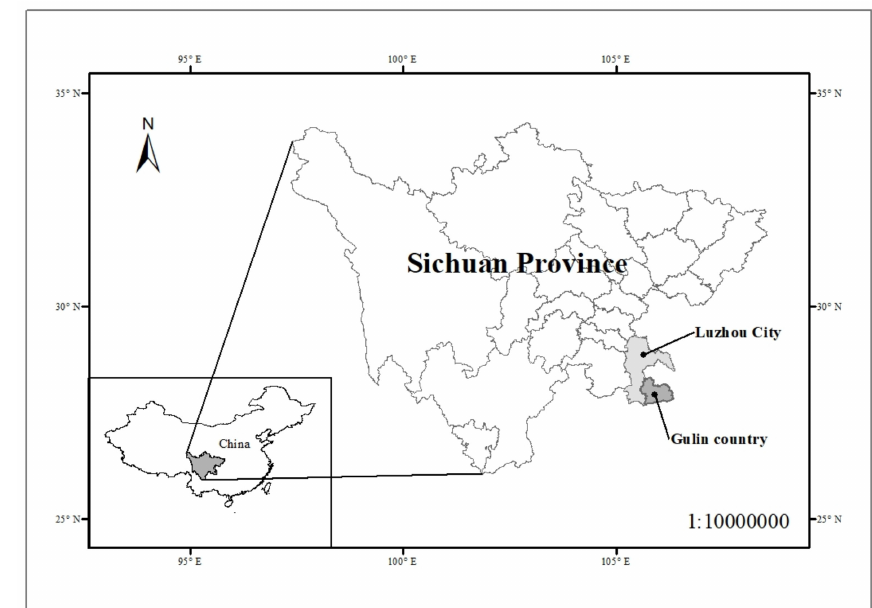
Figure A1. Location of the study